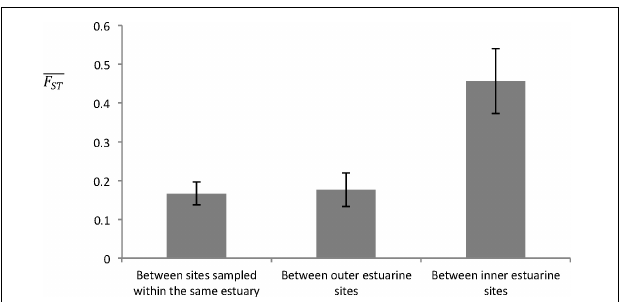
FIGURE 4 | Mean (and SE) F ST values calculated between sites within the same estuary, between outer estuarine sites, and between inner estuarine sites in Galicia using eight microsatellite loci. The two populations from the Ría de Muros e Noia, San Francisco and Bornalle, were not included since only three specimens of Phymatolithon calcareum were sampled in San Francisco (i.e., outer-zone, see Figure 2 ). F ST values correspond to the ones calculated using the whole data set (i.e., the “ramets” data